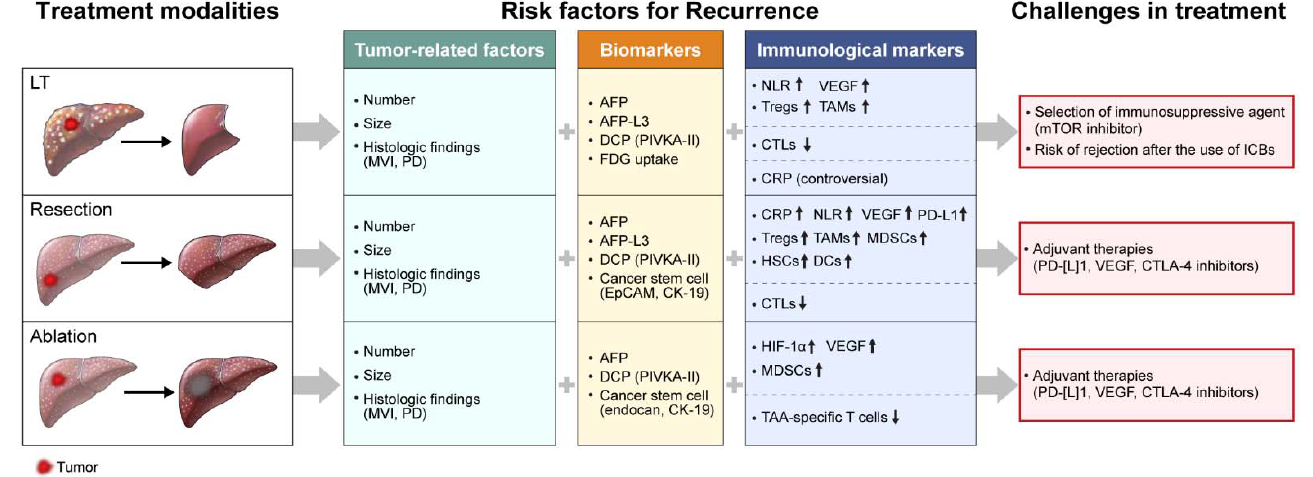
Figure 1. Risk factors for recurrence and challenges following curative treatments for hepatocellular carcinoma. LT, liver transplantation; MVI, microvascular invasion; PD, poor differentiation; AFP, alpha-fetoprotein; AFP-L3, Lens culinaris agglutinin-reactive alpha-fetoprotein; DCP, des-gamma-carboxyprothrombin; PVIKA-II, protein induced by vitamin K absence or antagonist-II; FDG, fluorodeoxyglucose; EpCAM, epithelial cell adhesion molecule; CK-19, cytokeratin-19; NLR, neutrophil-to-lymphocyte ratio; VEGF, vascular endothelial growth factor; Treg, regulatory T cell; TAM, tumor-associated macrophage; CTL, cytotoxic T-cell; CRP, C-reactive protein; PD-L1, programmed cell death ligand 1; MDSC, myeloid-derived suppressor cell; HSC, hepatic stellate cell; DC, dendritic cell; HIF-1 α , hypoxia inducible factor-1 alpha; TAA, tumor-associated antigen; mTOR, mammalian target of rapamycin; ICB, immune checkpoint blocker; PD-1, programmed cell death protein 1; CTLA-4, cytotoxic T-lymphocyte-associated antigen 4.